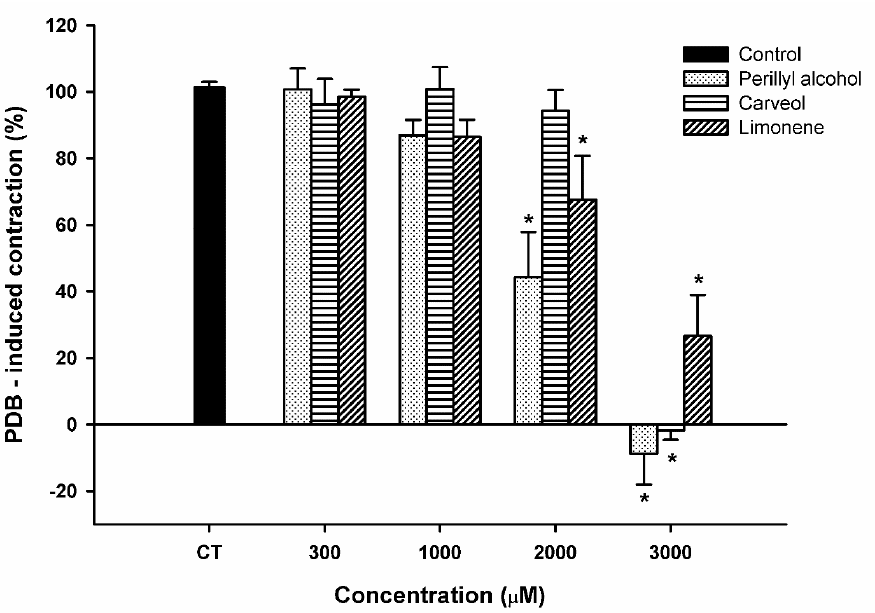
Figure 6. Relaxant effect of perillyl alcohol, carveol, and limonene on sustained contractions induced by PDB (1 μM) in endothelium-denuded rat aortic rings. Results are shown as means ± SEM. * indicates a significant effect ( p < 0.05, ANOVA on Rank’s followed by Dunn’s test).